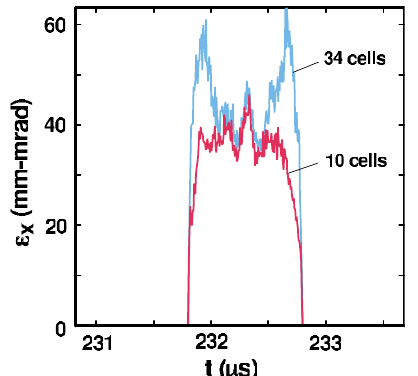
FIG. 8. (Color) Snapshots of the x emittance after 15 laps for a lattice with 34 cells per lap and one with 10. Trapezoidal pulses adjusted to give the same overall compression have been used in all